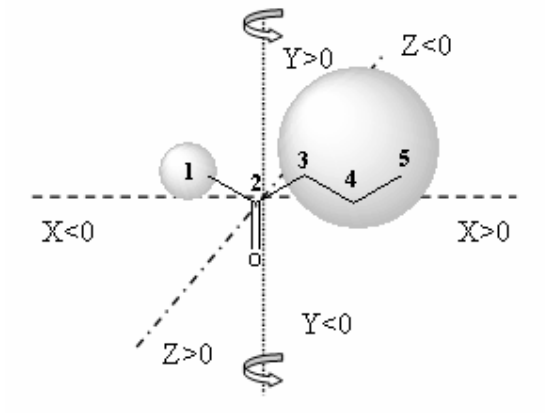
Figure 5. Alignment rule of the ketones for CoMFA study